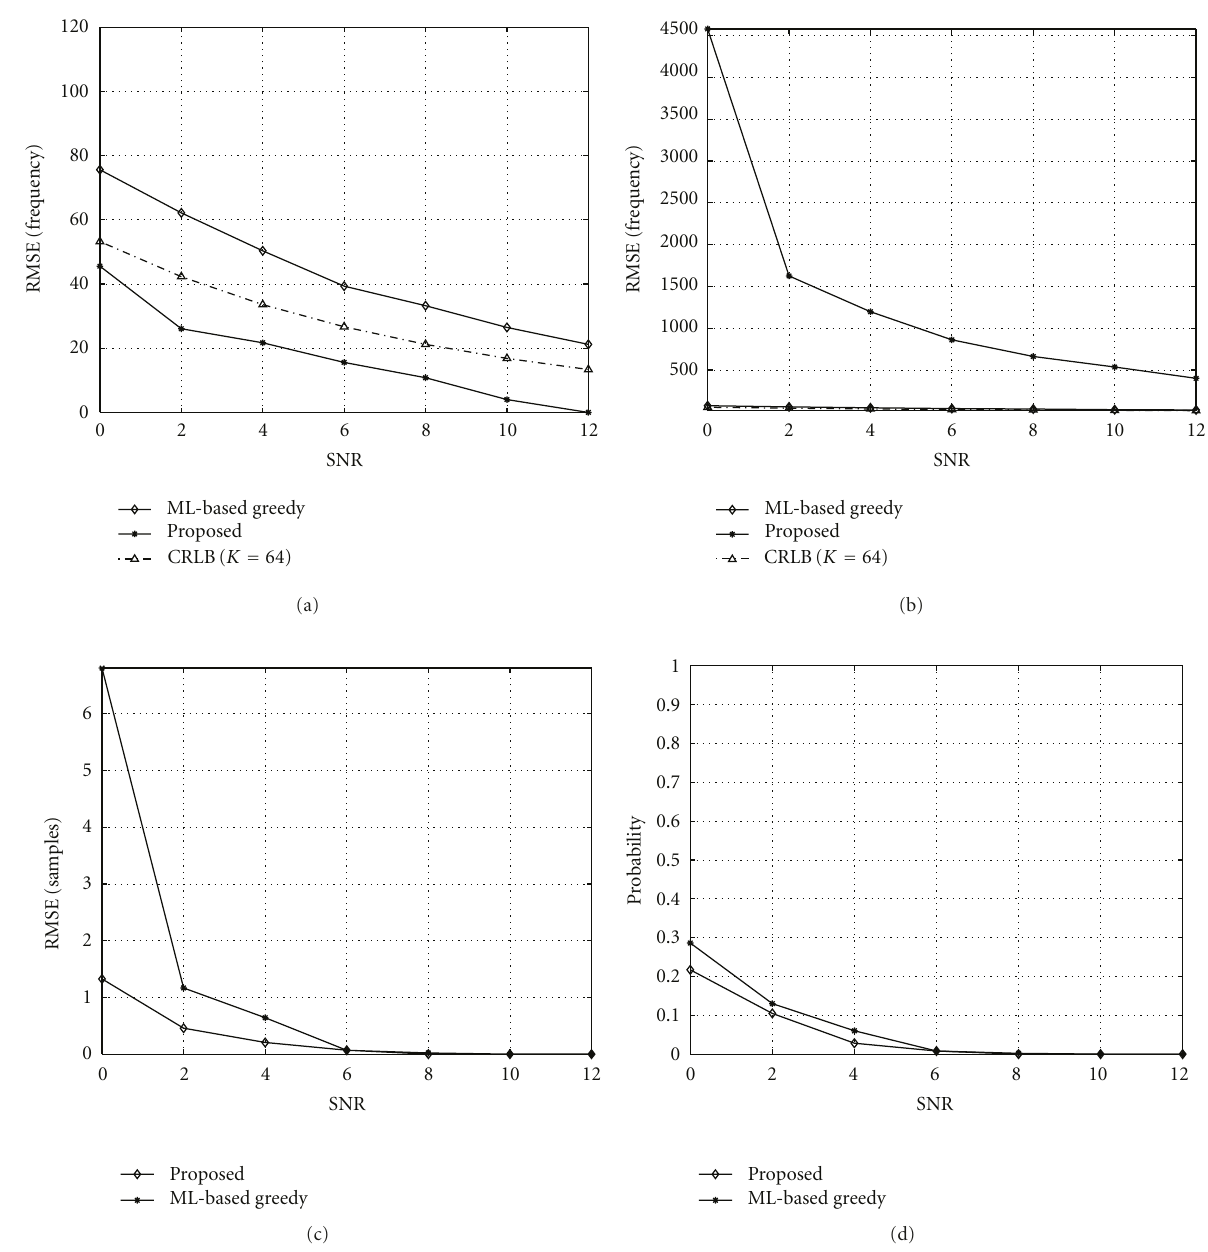
Figure 5: Root mean square estimation error versus SNR with K = 120. (a) RMSE of f 1 estimate, (b) RMSE of f 2 estimate, (c) RMSE of K estimate, and (d) error probability of K